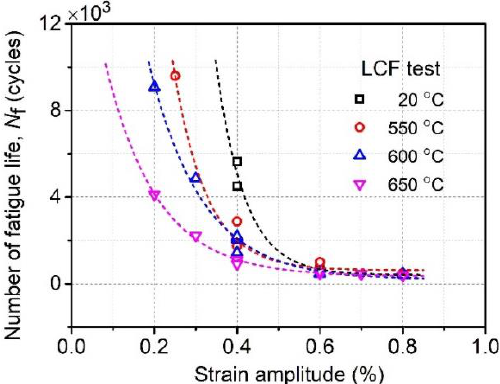
Figure 2. Relationships between the fatigue life and total strain amplitude at different temperatures.